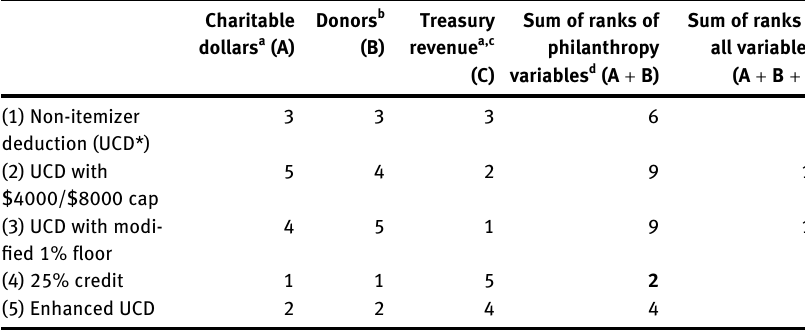
Table  : Aggregate-summary statistic based on the ranks of effects of fi ve policy options on charitable giving, number of donors, and Treasury revenues in 